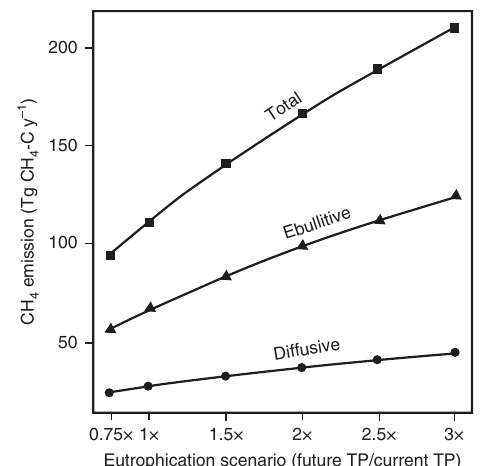
Fig. 2 Simulated future global emissions of CH 4 calculated at multiple levels of increased eutrophication driven by accelerated TP loading to lakes and impoundments (see Methods). The scenarios are based on a review of the published literature and re fl ect future TP concentrations that are 0.75, 1.5, 2, 2.5, and 3× greater (i.e., 0.75×, 1.5×, 2×, 2.5×, 3×) than current levels (1×), as indicated on x -axis. Simulated TP concentration was converted to chlorophyll a (chla) using published data (see Methods and Supplementary Figure 1) resulting in future chla concentrations that are 0.8, 1.3, 1.7, 2.0, and 2.2× that of current levels. CH 4 emissions were predicted from